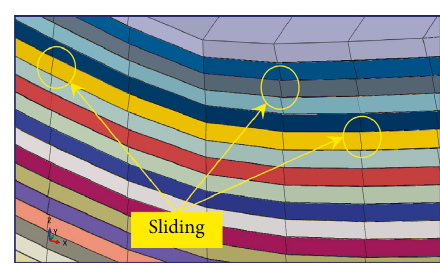
Figure 6: Sliding between adjacent plies along x